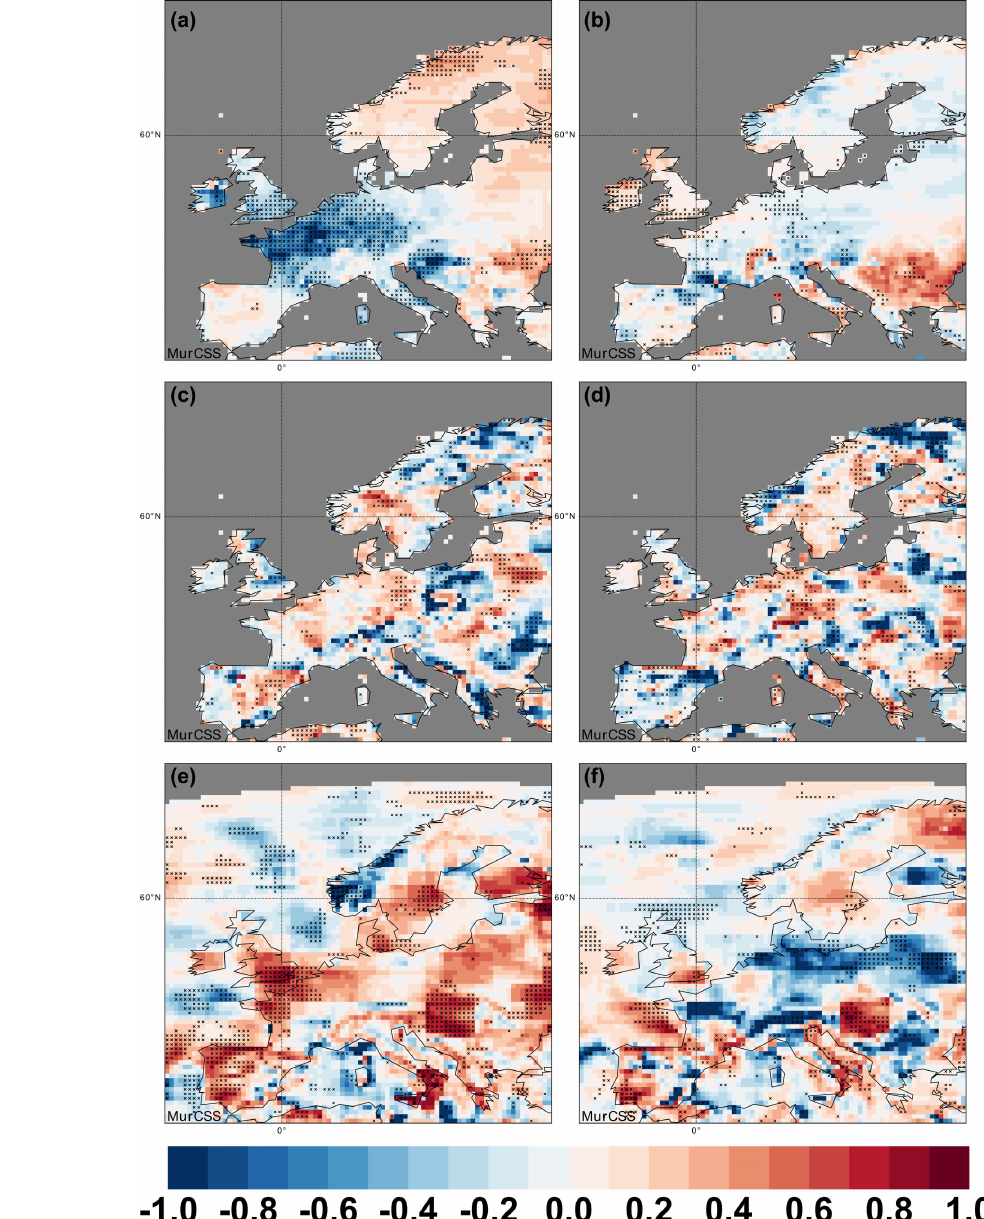
Figure 4. Spatial distribution of the MSESS for the multi-annual mean anomalies of lead years 1–5 for (a) temperature in CCLM_b0, (b) temperature in CCLM_b1, (c) precipitation in CCLM_b0, (d) precipitation in CCLM_b1, (e) wind speed in CCLM_b0, and (f) wind speed in CCLM_b1. As reference dataset we have used the respective global MPI data. The black dots indicate significant skill at the 95% level